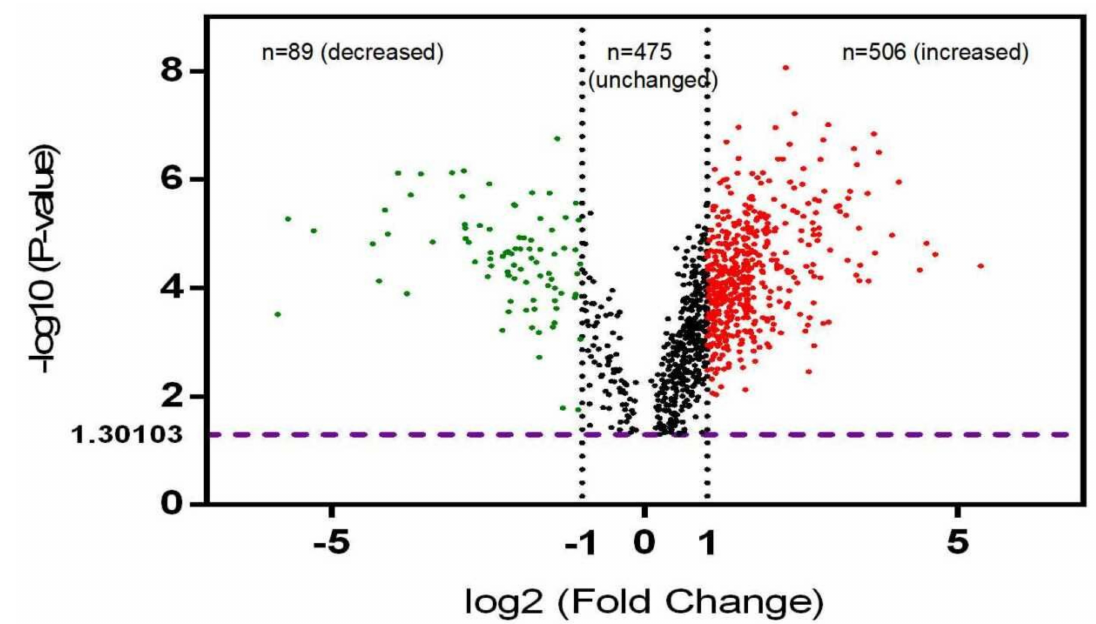
Figure 3. The volcano plot for 595 differentially phosphorylated proteins (DPPs) between NF-PitNETs and controls. The abscissa represents the logarithm of the expression level difference from a certain protein in NF-PitNETs and controls, namely log2(FC). The greater the absolute value of abscissa, the greater the expression with multiple differences between NF-PitNETs and controls. The y-coordinate represents the negative log of p -value, namely the − log10( p -value). The larger the ordinate value, the more significant DPPs were, and the more reliable the screened DPPs